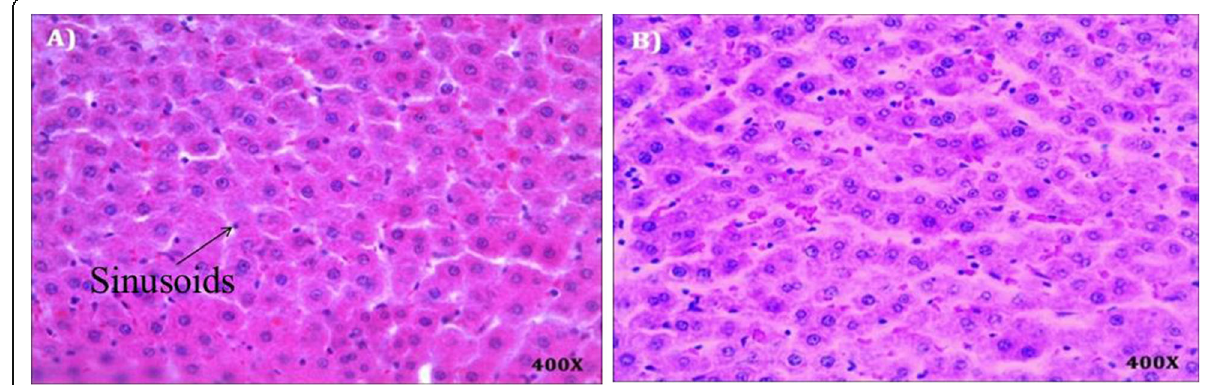
Fig. 1 Light micrographs of rat liver tissue in ( a ) control group and ( b ) treated group